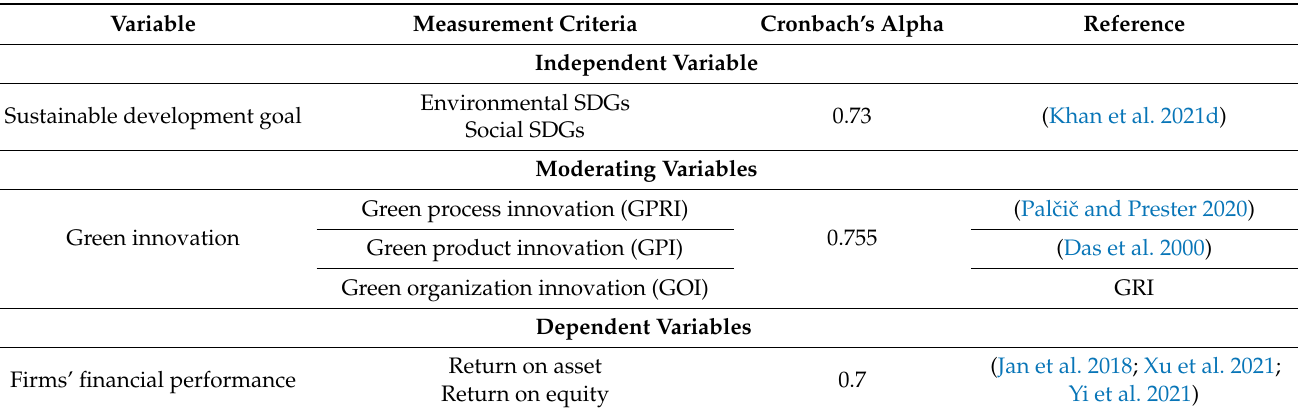
Table 3. Reliability and validity